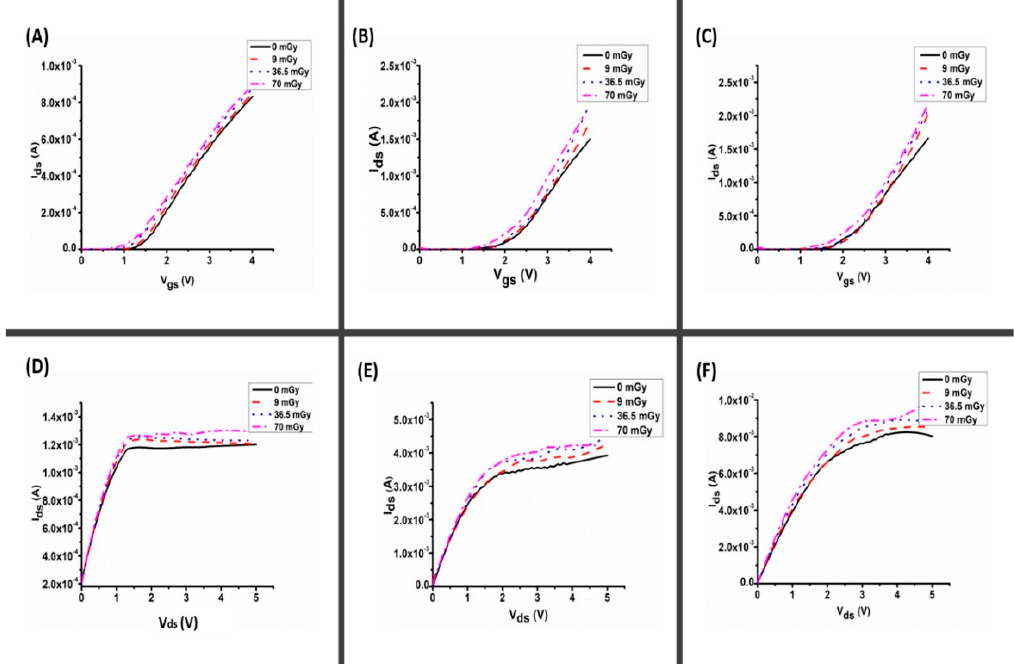
Figure 7. I–V characterization of AZO (disk type) for ( A – C ) transfer characteristics for bias voltage 0.3, 1 and 3 V, respectively, and ( D – F ) output characteristics for bias voltage 3, 5 and 7 V, respectively.